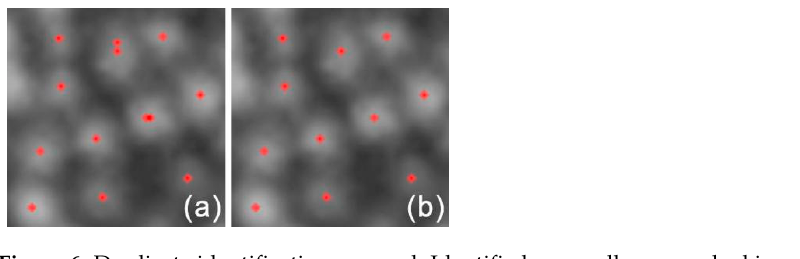
Figure 5. Cone cell identification based on K -means clustering. ( a ) Denoised AO-SLO image patch. ( b ) Identified cone cells marked in red on denoised AO-SLO image patch.